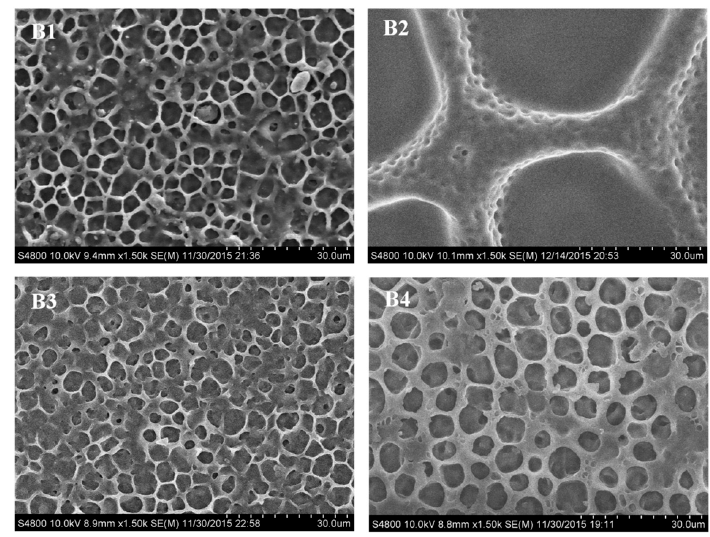
Figure 4. SEM micrographs of the polymer networks of the samples B1–B4.